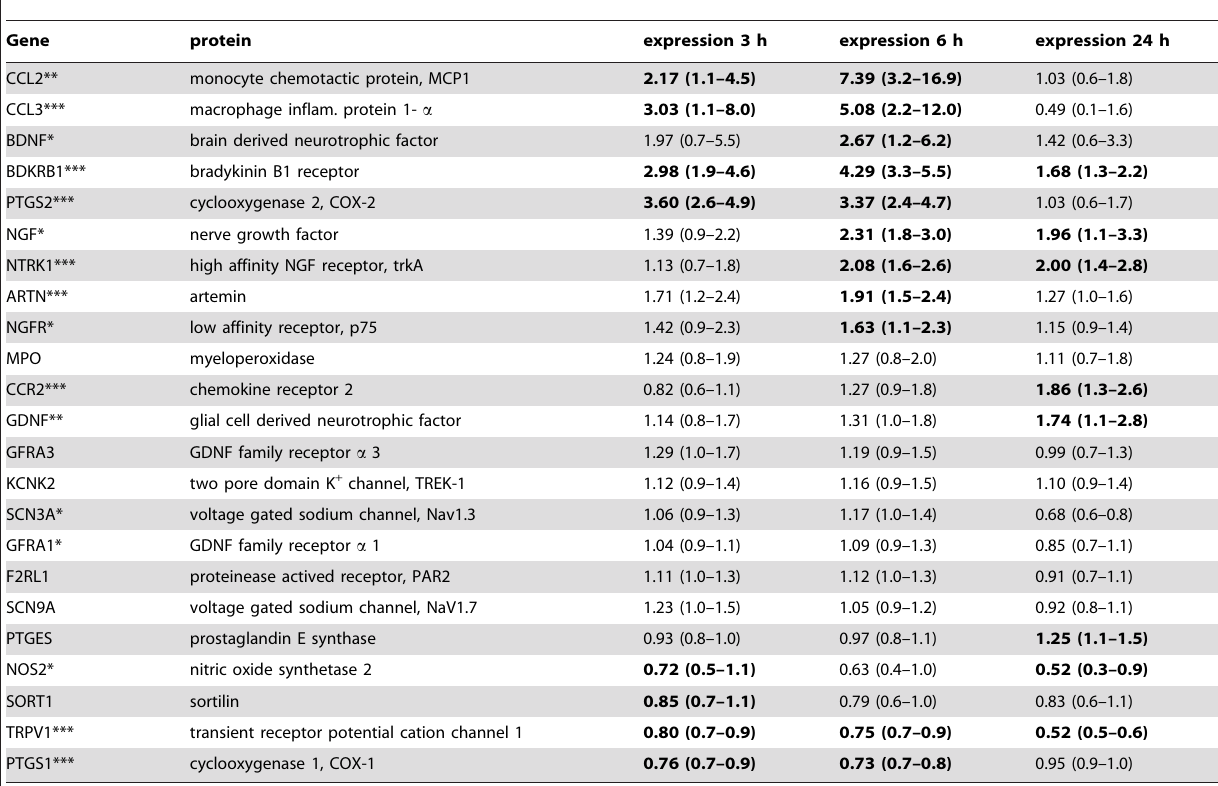
Table 1. Compilation of relative gene expression 3, 6 and 24 h after UV-C irradiation (n=14).